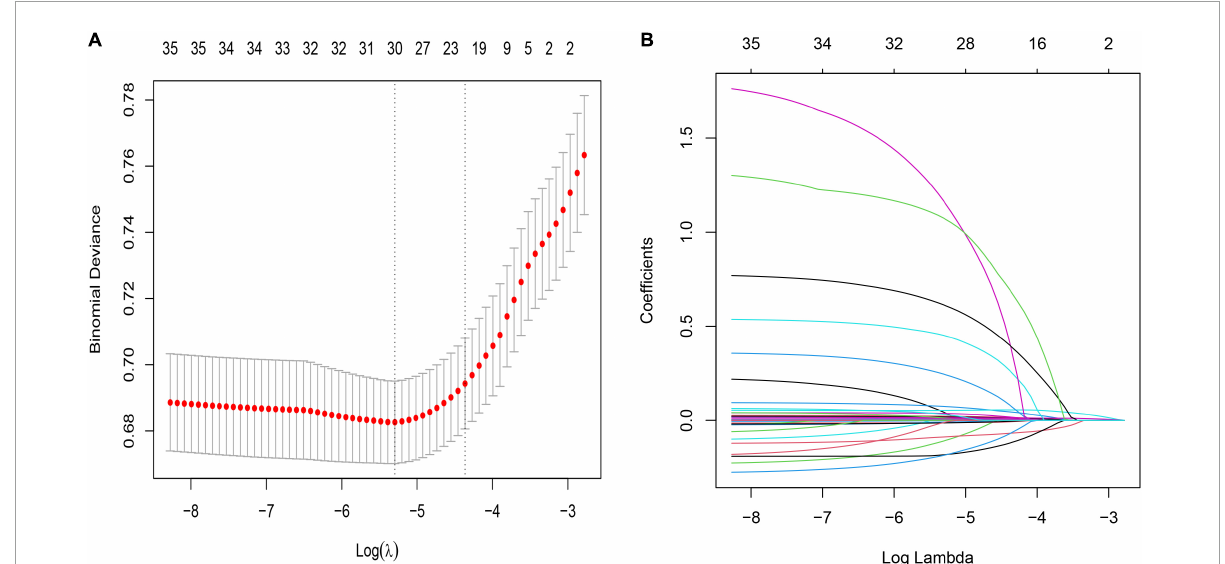
FIGURE2 Demographic and clinical feature selection using the least absolute shrinkage and selection operator (LASSO) binary logistic regression model. (A) Tuning parameter ( λ ) selection in the LASSO model used 10- fold cross-validation via minimum criteria. The partial likelihood deviance (binomial deviance) curve was plotted versus log( λ ). Dotted vertical lines were drawn at the optimal values by using the minimum criteria and the one SE of the minimum criteria (the 1-SE criteria). λ value of 0.01914052, with log( λ ), − 3.9545 was chosen (1- SE criteria) according to 10-fold cross-validation. (B) LASSO coefficient profiles of the 58 features. A coefficient profile plot was produced against the log( λ ) sequence. The vertical line was drawn at the value selected using 10-fold cross-validation, where optimal resulted in 20 features with non-zero coefficients.